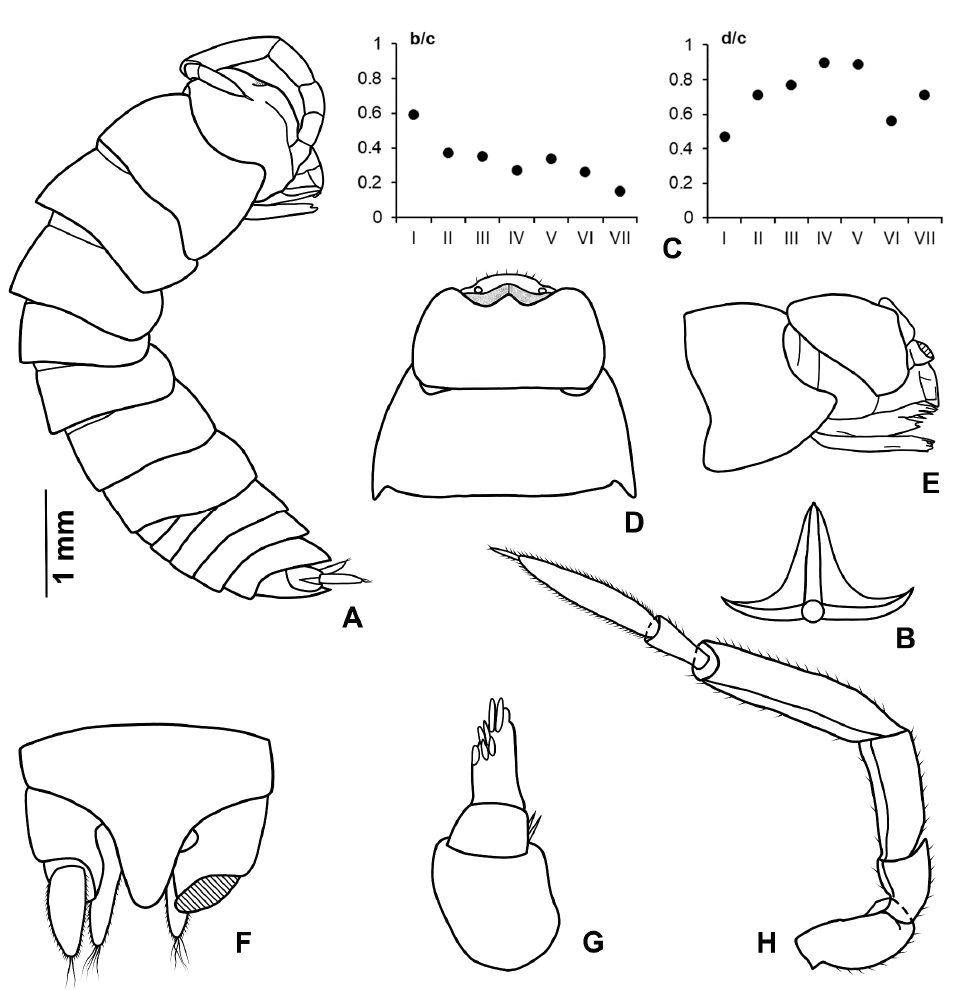
Figure 7. Cylisticus poggii sp. n. ( A ) Paratype ♀ from Isola del Tino. ( B – H ) Paratype ♂ , same locality. ( A ) Specimen in lateral view. ( B ) Dorsal scale-seta. ( C ) Coordinates of noduli laterales. ( D ) Cephalon and pereonite 1, dorsal view. ( E ) Cephalon and pereonite 1, lateral view. ( F ) Telson and uropods, dorsal view. ( G ) Antennula. ( H ) Antenna.